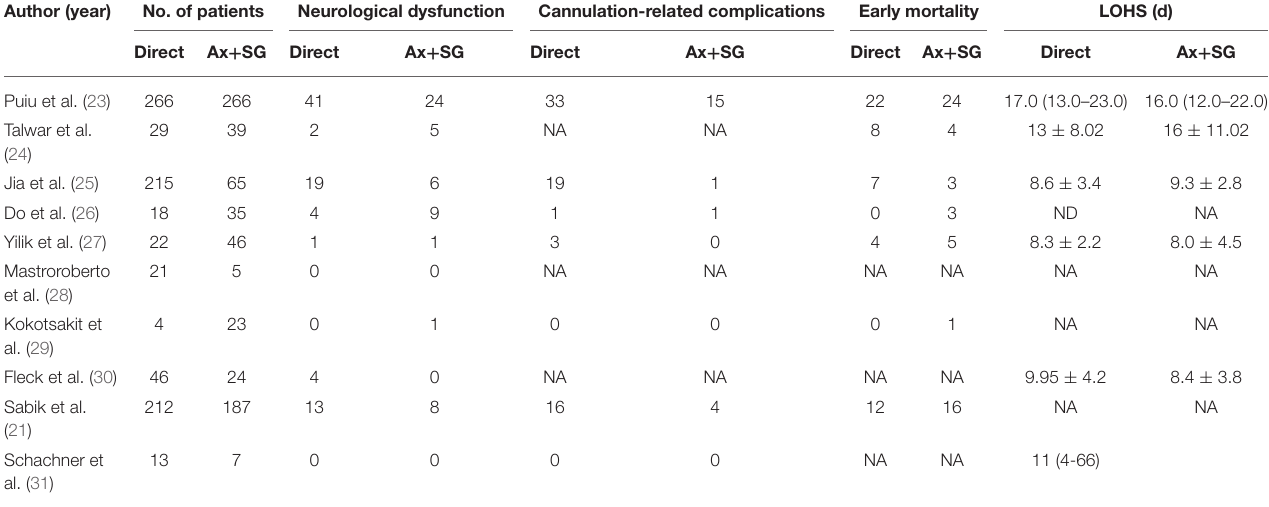
TABLE 3 | Outcomes of ten eligible studies.